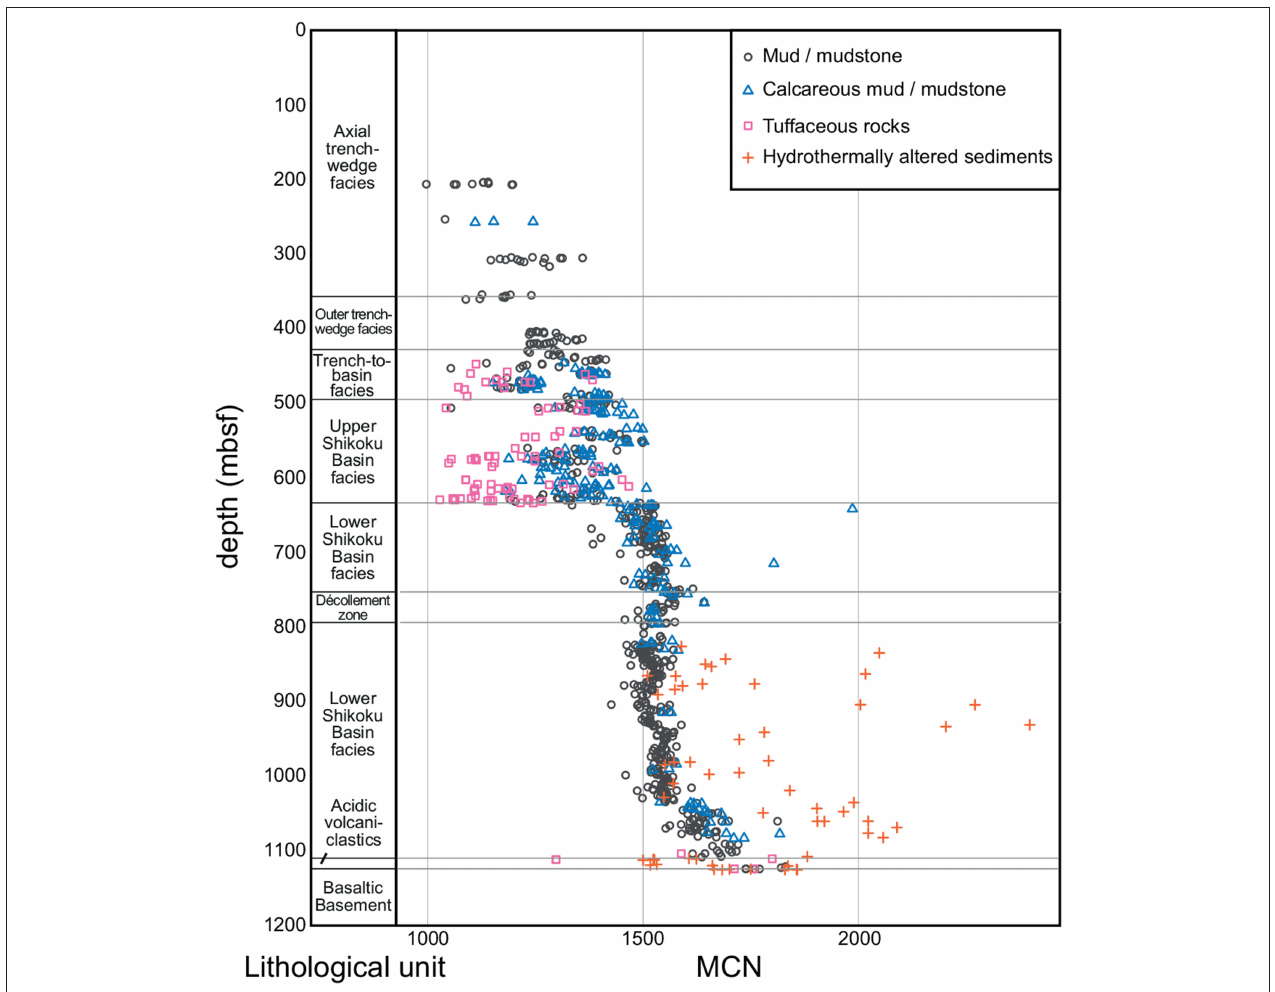
FIGURE 5 | Relationship between graphic lithology and MCN of the IODP Site C0023. Graphic lithology data are from Heuer et al.